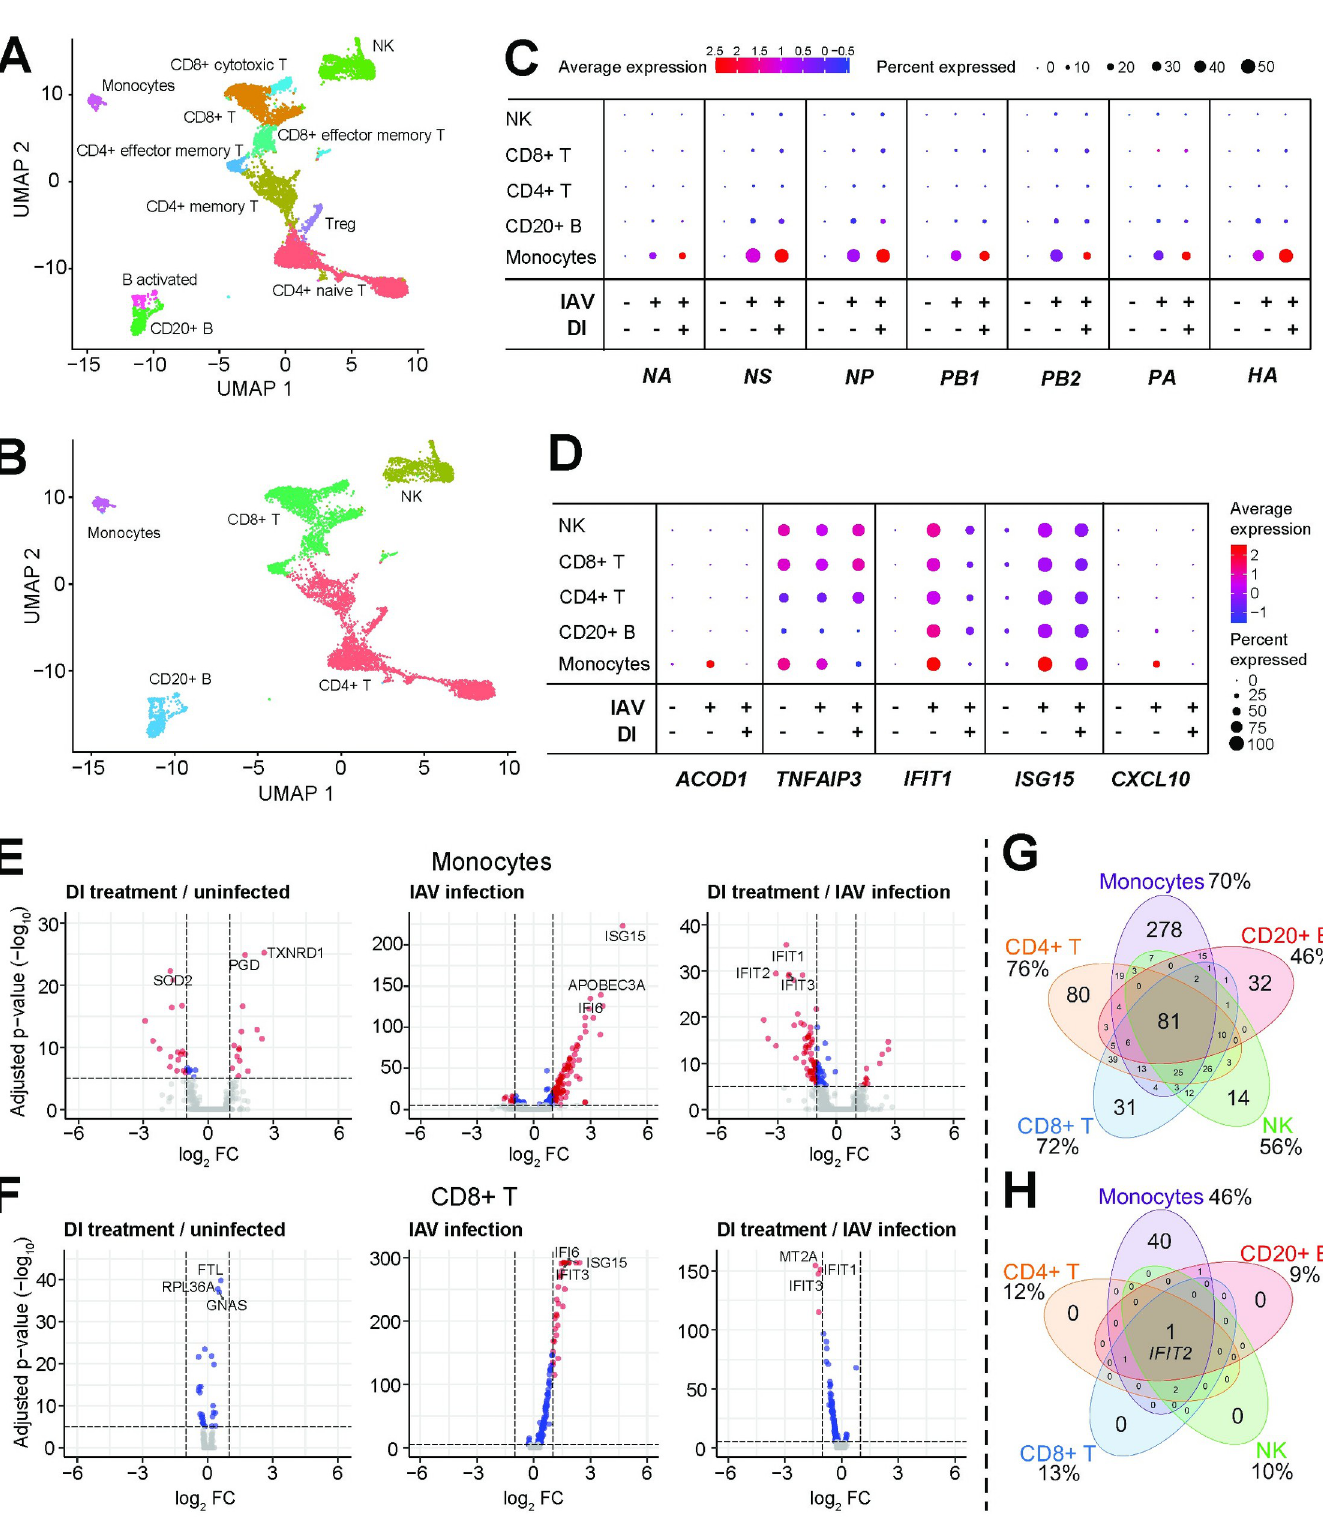
Fig 9. Single-cell transcriptomic responses of PBMCs to IAV infection and DI treatment. PBMCs were isolated from freshly donated human blood (one donor), and then infected with IAV (PR8M, MOI = 1) for 12 h with or without DI (0.5 mM) in the medium. A,B . UMAP plots identifying 13 cell types ( A ) that make up the five major cell types ( B ) studied. The RNA cell markers used are listed in Table 4 . C,D. Differential mRNA expression in uninfected, infected and infected/DI-treated PBMCs.